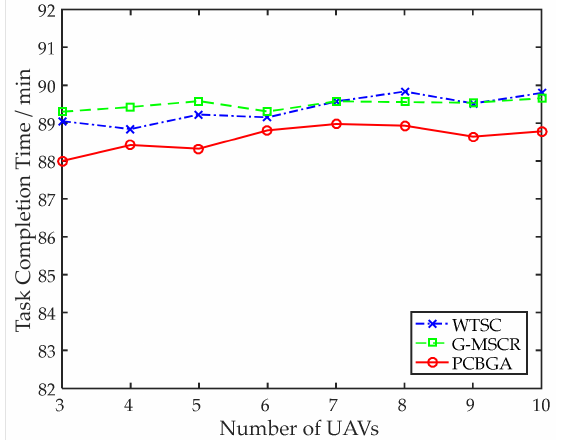
Figure 6. Comparison of the task completion time with the increase of UAVs.